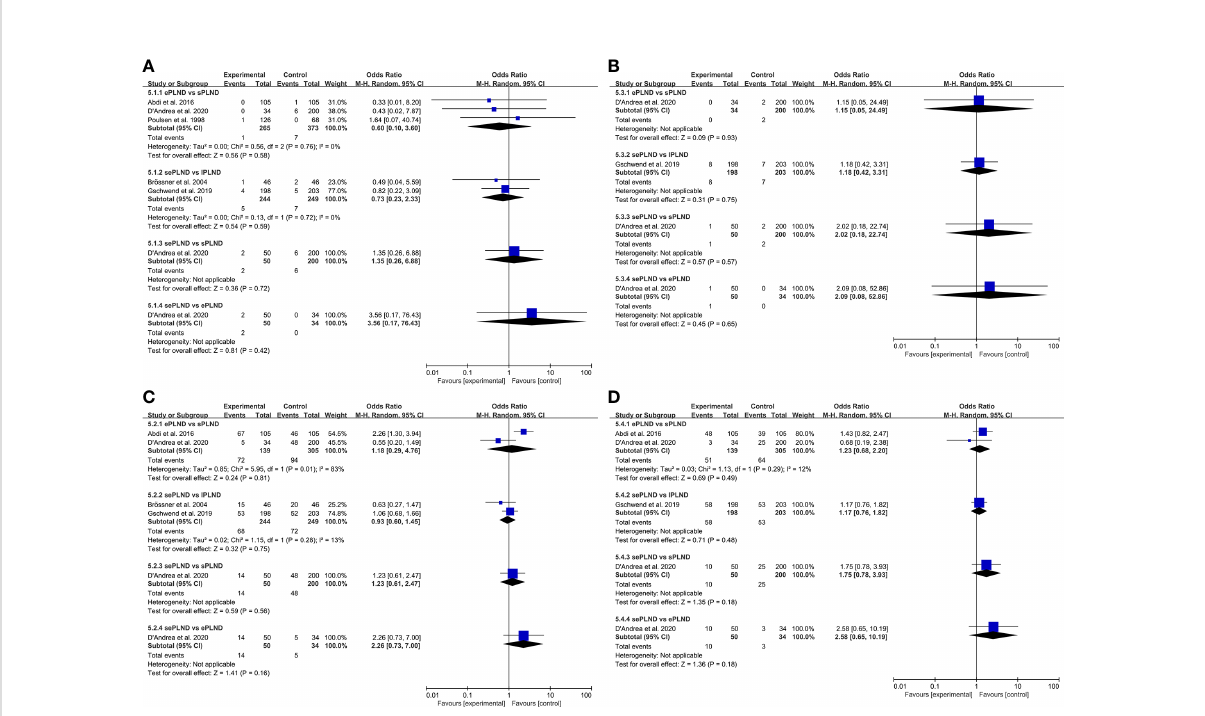
FIGURE 3 (A) Forest plot for direct comparisons of early Clavien-Dindo grade 5 complications rates in patients with different PLND templates. (B) Forest plot for direct comparisons of late Clavien-Dindo grade 5 complications rates in patients with different PLND templates. (C) Forest plot for direct comparisons of early Clavien-Dindo grade 3-4 complications rates in patients with different PLND templates. (D) Forest plot for direct comparisons of late Clavien-Dindo grade 3-4 complications rates in patients with different PLND templates. PLND, Pelvic lymph node dissection. CI, con fi dence interval. lPLND, limited pelvic lymph node dissection. sPLND, standard pelvic lymph node dissection. ePLND, extended pelvic lymph node dissection. sePLND, super-extended pelvic lymph node dissection.